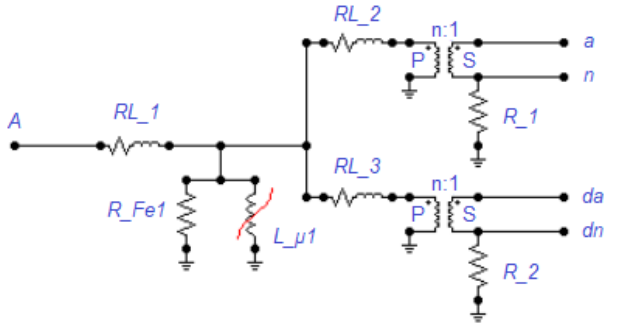
Figure 2. Model of single-phase voltage transformer for phase L 1 made in EMTP/ATP